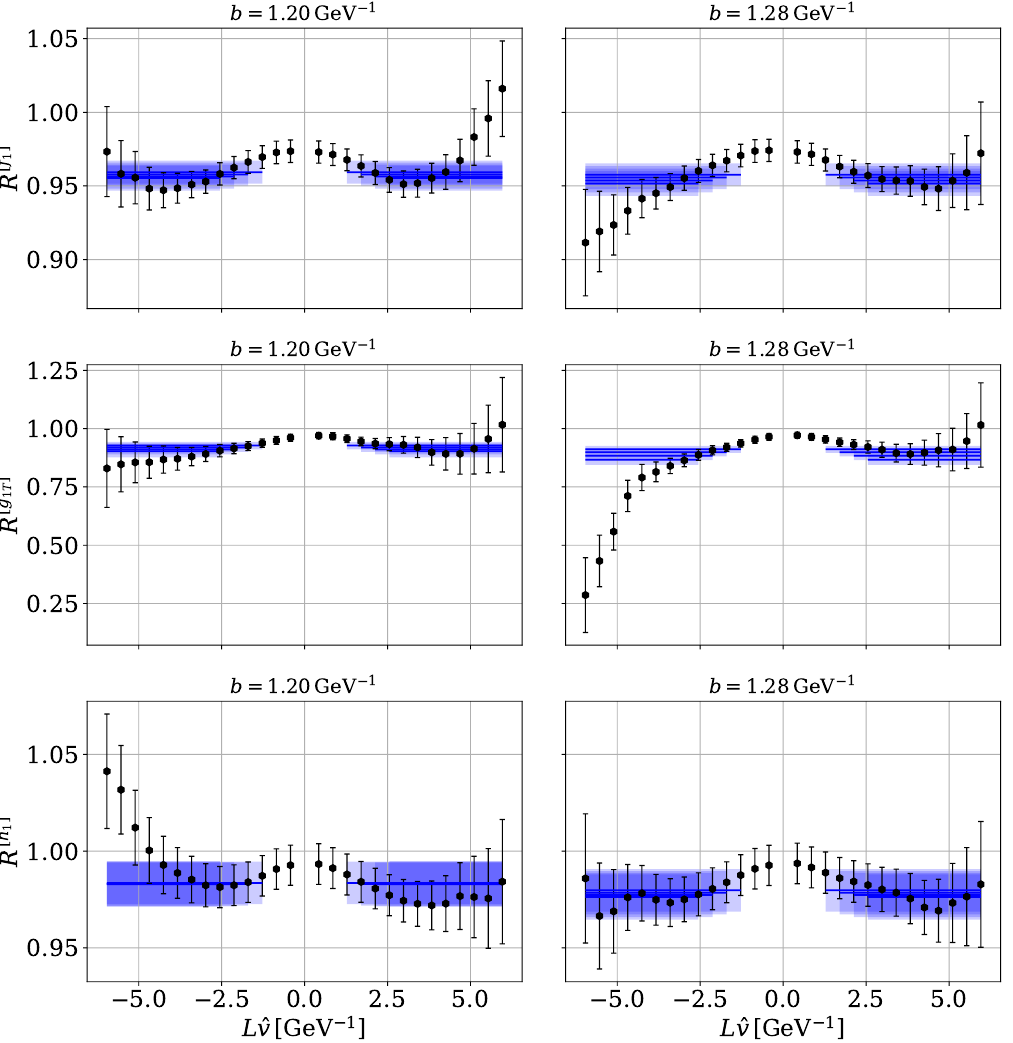
Figure 5 . Lattice results for the ratios between different momenta including the plateau fit for different fit ranges including the jackknife error of the fit. The shown values of b are used to determine M [Γ] from these